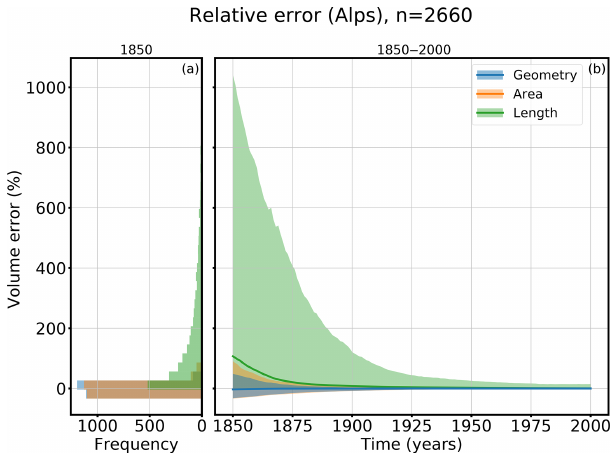
Figure 9. Relative volume errors of s min t derived from different fit- ness functions based on the geometry (blue), glacier area (orange), and glacier length (green). Panel (a) shows a histogram of all rela- tive errors in the 5th–95th percentiles in the year 1850 and (b) the evolution of the relative errors from 1850 to 2000. The line shows the median error and the shadowed area the 5th–95th percentile